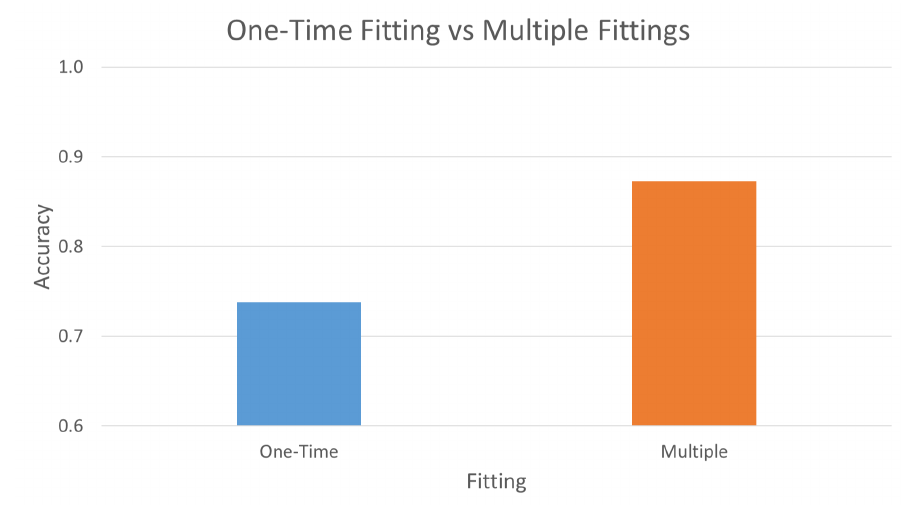
Figure 11 show the comparison of non-rotation training data versus virtually rotation training data. The training data set of the bars on the left consist of 3 scenarios × 6 fittings × 5 gestures, whereas the training data set of the bars on the right consist of 3 scenarios × 6 fittings × 5 gestures × 8 rotations. Both testing data sets consist of 3 scenarios × 2 fittings × 5 gestures. The data was trained with k-fold cross validation without overlapping. Cross validation was used to check the independence of the data. The non-rotation training data (blue bars) uses 2-fold cross